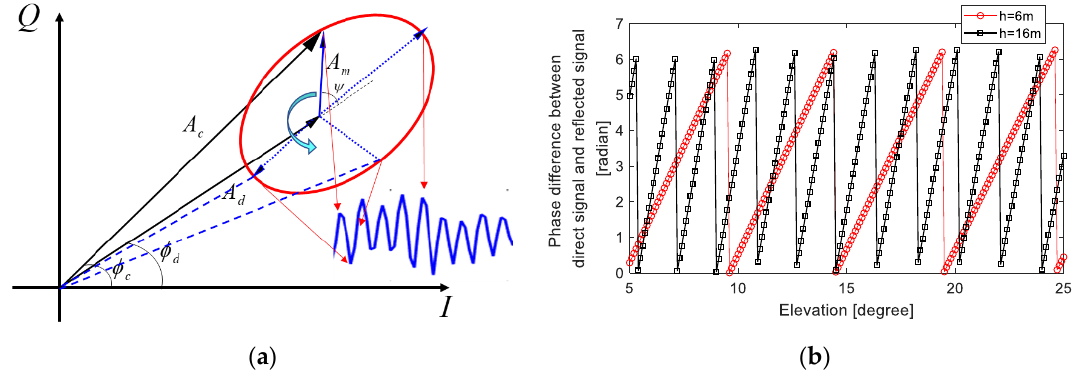
Figure 2. ( a ) Schematic diagram of interference signal vector decomposition; ( b ) Relationship between elevation angle and ϕ for two di ff erent heights.